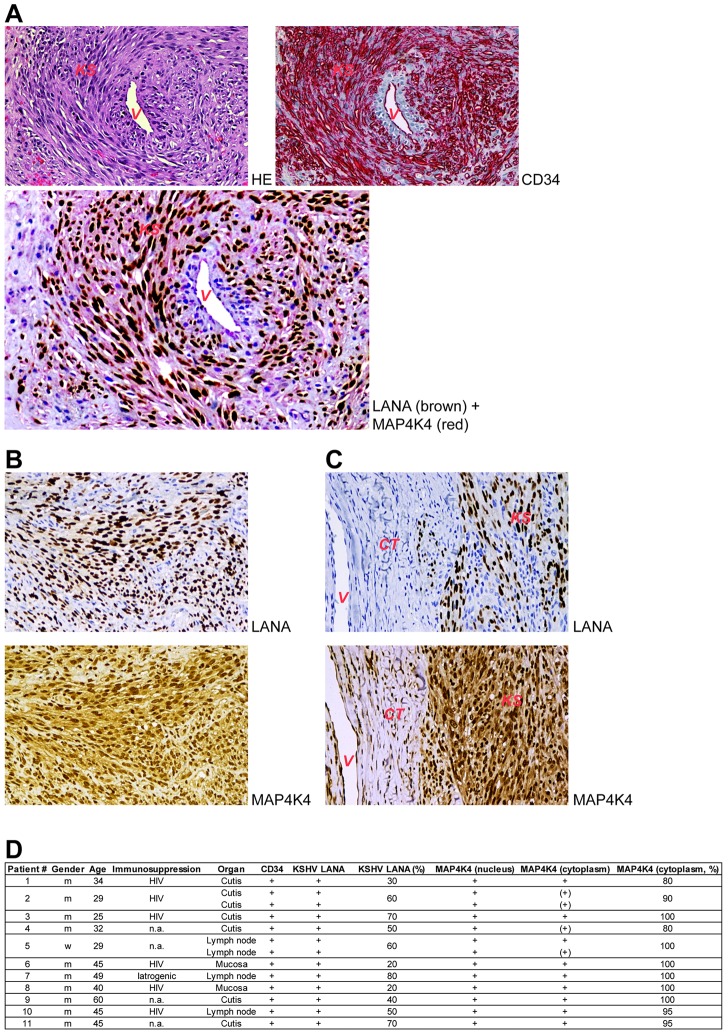
MAP4K4 is expressed in endothelial spindle cells in KS tumours.(A) Subepidermal Kaposi's sarcoma [KS] surrounding and infiltrating a non-neoplastic blood vessel [V]. The tumour cells express CD34 (red; the non-neoplastic endothelial cells of the blood vessel are CD34 positive, too) and nuclear LANA (dark brown), as well as cytoplasmic MAP4K4 (light red; double-staining). (B) Kaposi's sarcoma completely replacing the lymphatic tissue of a lymph node. Nuclear LANA protein expression is observed in 50–70% of tumour cells (dark-brown) and cytoplasmic MAP4K4 expression – in more than 95% of sarcoma cells (brown). (C) Kaposi's sarcoma [KS] partly expressing LANA and infiltrating non-neoplastic subepidermal connective tissue [CT] with a non-neoplastic blood vessel [V]. Strong cytoplasmic MAP4K4 positivity is seen in KS cells, while only weak MAP4K4 expression is present in non-neoplastic endothelial cells [V]. All images are presented in 250× magnification. (D) Summary of MAP4K4 expression in 13 KS biopsies.